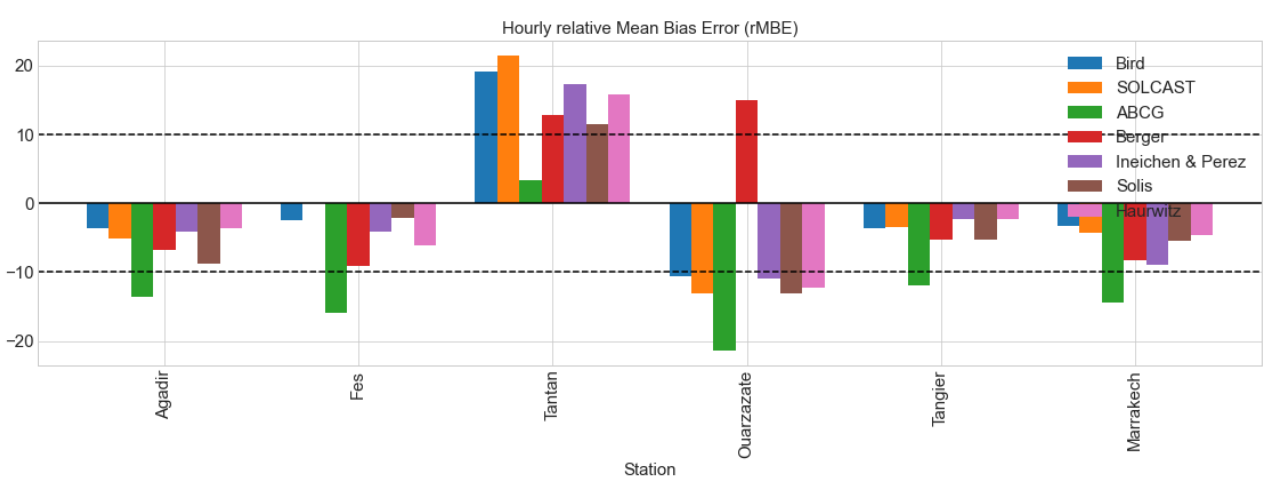
Figure 3. Hourly relative mean bias error (rMBE) of modelled clear sky GHI against McClear clear sky GHI.